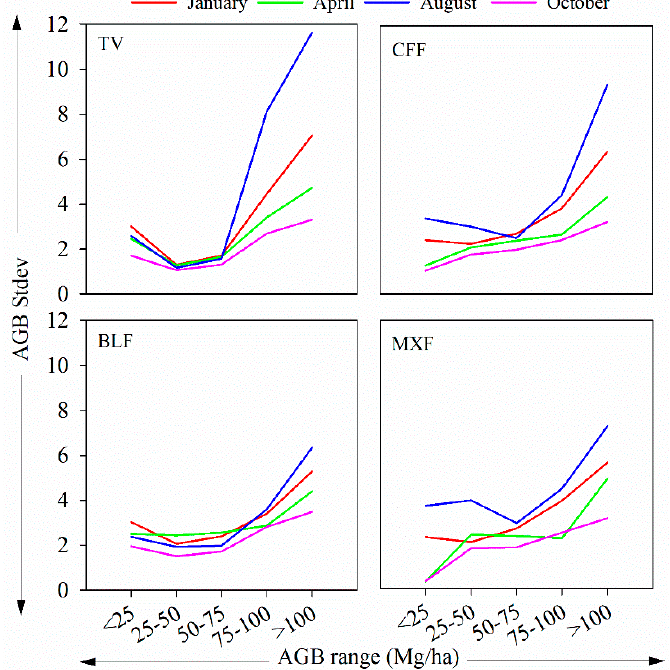
Figure 6. Standard deviation (Stdev) maps of AGB values using seasonal images under di ff erent scenarios: ( a ) The total vegetation; ( b ) forest types including coniferous forest, broadleaf forest and mixed forest.